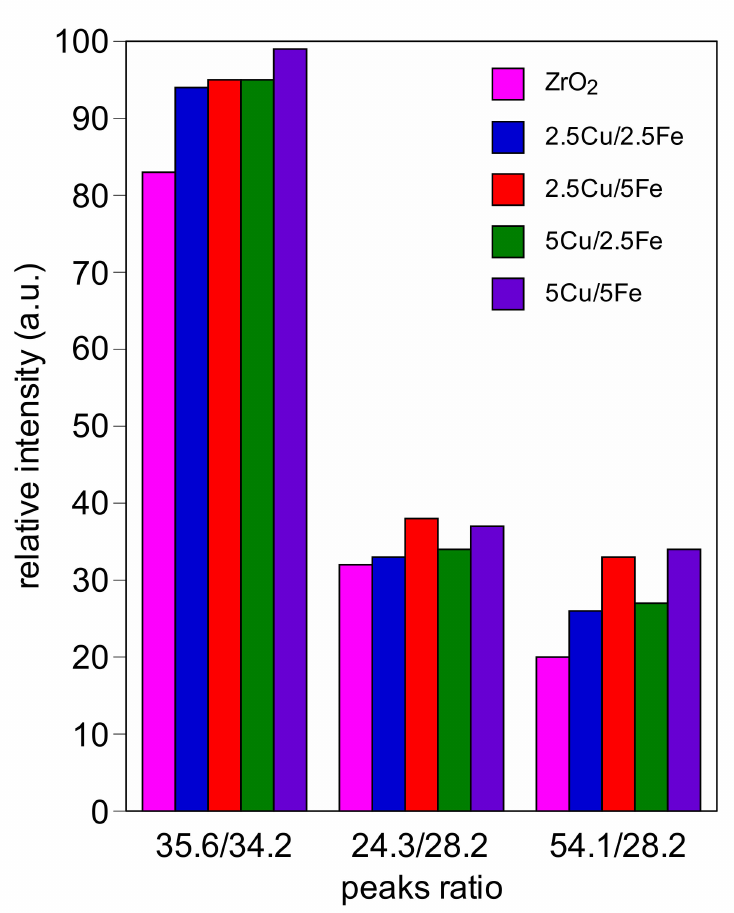
Figure 2. Relative intensity of main characteristic signals of ZrO 2 , Fe 2 O 3 and CuO. The reduction behavior of the bimetallic catalysts has been investigated by means of H 2 temperature-programmed reduction experiments (H 2 -TPR) (Figure 3). All the materials exhibit four peaks due to the reduction in CuO and Fe 2 O 3 [37]. Specifically, the reduction profile is characterized by three peaks in the temperature range 120–300 ◦ C: the first one ( α peak), in the range 140–150 ◦ C is attributed to the reduction in highly dispersed CuO, while the signal in the range 230–265 ◦ C ( γ peak), is due to the reduction in bulk CuO [38]. The second signal at 200–220 ◦ C ( β peak) corresponds with the reduction of Fe 2 O 3 to Fe 3 O 4 . Finally, at 300–400 ◦ C a broad signal ( δ peak) is found due to the further reduction of Fe 3 O 4 to Fe [39]. Samples with 5% of Fe show a more intense β peak and a broad δ peak compared to formulations with 2.5%, as expected, with no substantial changes in signal temperature. A more significant difference can be found for γ signals related to CuO reduction. Indeed, when the iron amount is 2.5 wt.%, the signals are in the range 255–265 ◦ C, while the peak is shifted to a lower temperature (230–240 ◦ C) for samples with 5 wt.% of iron (2.5Cu/5Fe and 5Cu/5Fe). The promotion of the reduction in CuO can be due to the synergistic effects between Fe 2 O 3 and CuO. This effect, related to the coupled redox cycles of copper (Cu 2+ /Cu + ) and iron (Fe +3 /Fe +2 ), improves the reducibility of the materials and is more pronounced with the 5Cu/5Fe formulation, which shows higher reducibility at a low